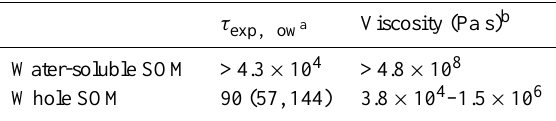
Table 2. Summary of τ exp, flow times and viscosities of whole SOM and water-soluble SOM produced in the flow tube at a production mass concentration of 14000µgm − 3 and studied at <0.5%